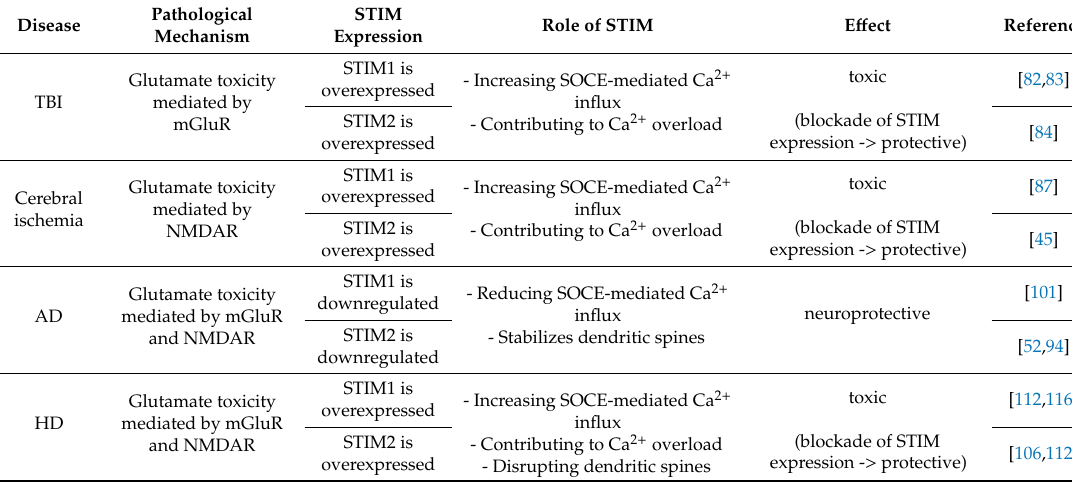
Summary of the functional significance of neuronal STIM proteins in neurodegenerative